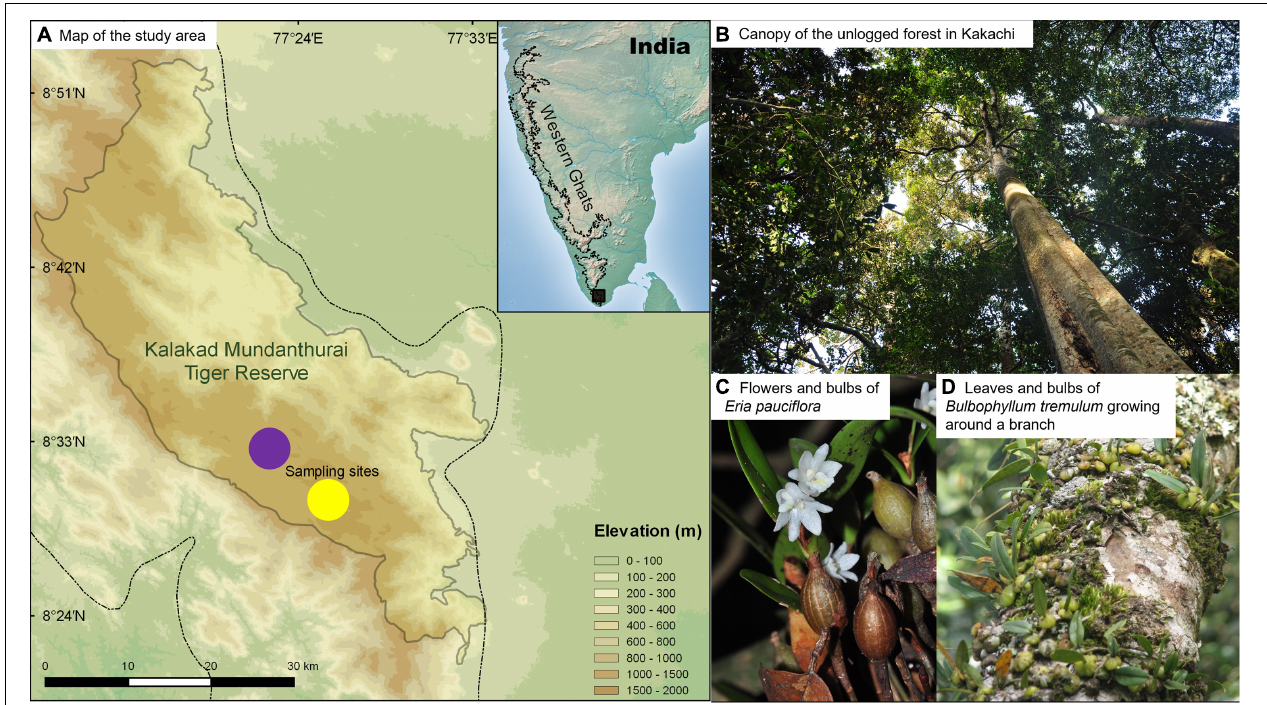
FIGURE 1 | (A) Map showing the study area. The dotted line indicates the Western Ghats. Circles represent the two sampling sites, Kakachi (purple, unlogged) and Kodayar (gold, selectively logged). (B) The forest canopy is seen from the ground in Kakachi. (C) Flowers and bulbs of Eria pauciflora. (D) Leaves and bulbs of Bulbophyllum tremulum growing around a branch of a Cullenia exarillata